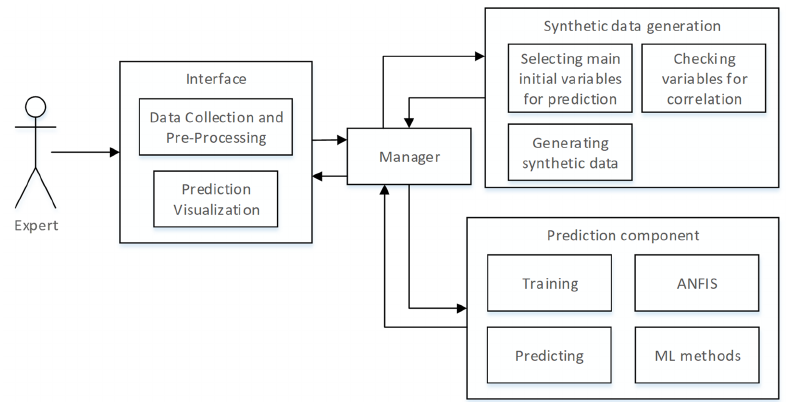
Figure 5. The conceptual architecture of the proposed approach to the prediction of the consequences of oil spills using small sets of data.